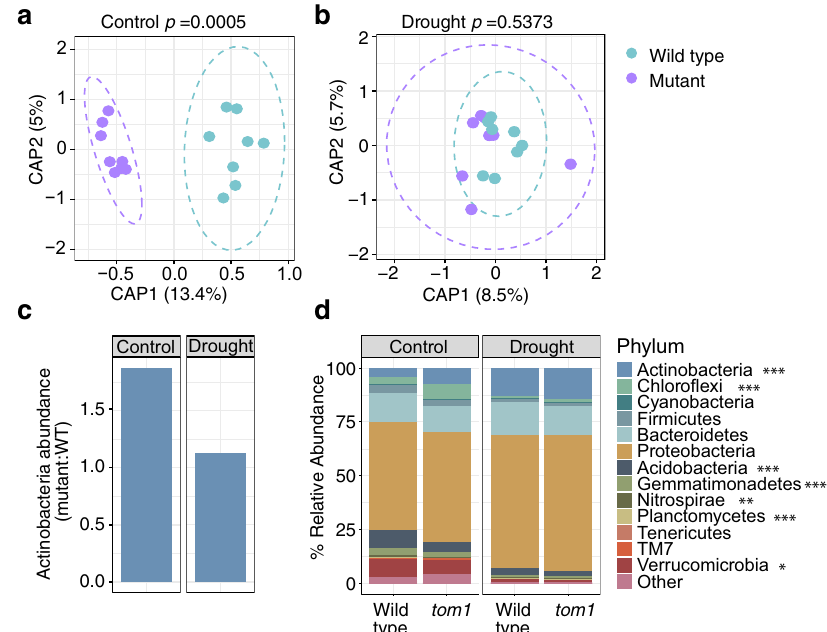
Fig. 6 TOM1 de fi ciency in plants shapes the composition of the rhizosphere microbial community. Constrained ordination of rhizosphere microbiome composition showing the effect of plant genotype (wild-type or tom1 mutant) under control ( a ) and drought ( b ) conditions. Ellipses show the parametric smallest area around the mean that contains 95% of the probability mass for each genotype. The p -value at the top of each plot represents the signi fi cance of the difference between WT and mutant, as evaluated by one-sided PERMANOVA. c The ratio of the relative abundance for Actinobacteria in tom1 vs. wild-type maize under control (left bar) and drought (right bar) conditions. d Relative abundance for the 13 most abundant bacterial phyla in the rhizosphere in both wild-type and tom1 mutant plants grown in the growth chamber for either 2.5 weeks of control (left facet) or drought (right facet) conditions. Signi fi cant differences in abundance between WT and the tom1 mutant under control conditions were determined by paired two-sided T-test, and are indicated with asterisks to the right of the phylum name: *, p < 0.05; **, p < 0.01; ***, p <